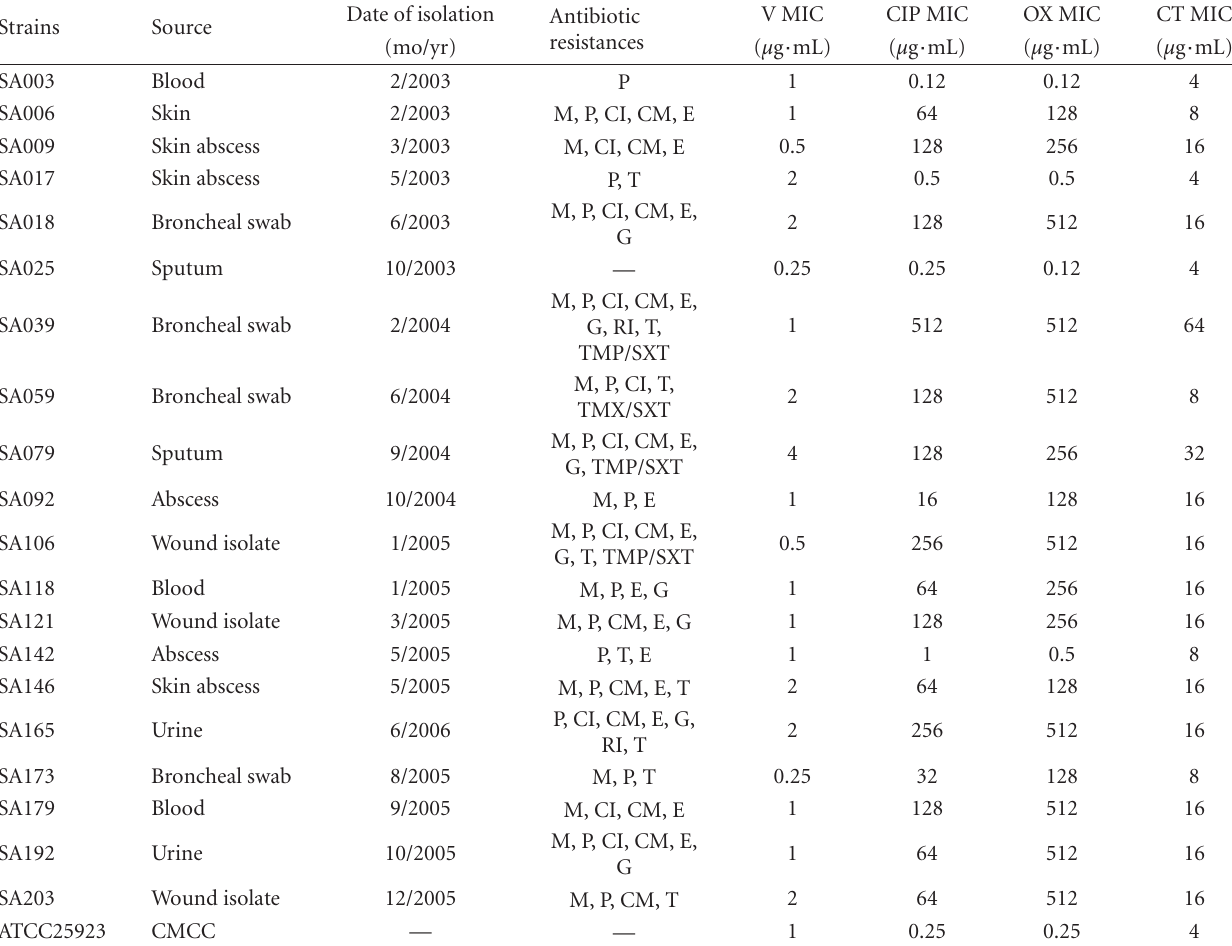
Table 1: Antibiograms of 21 Staphylococcus aureus strains used in this study.